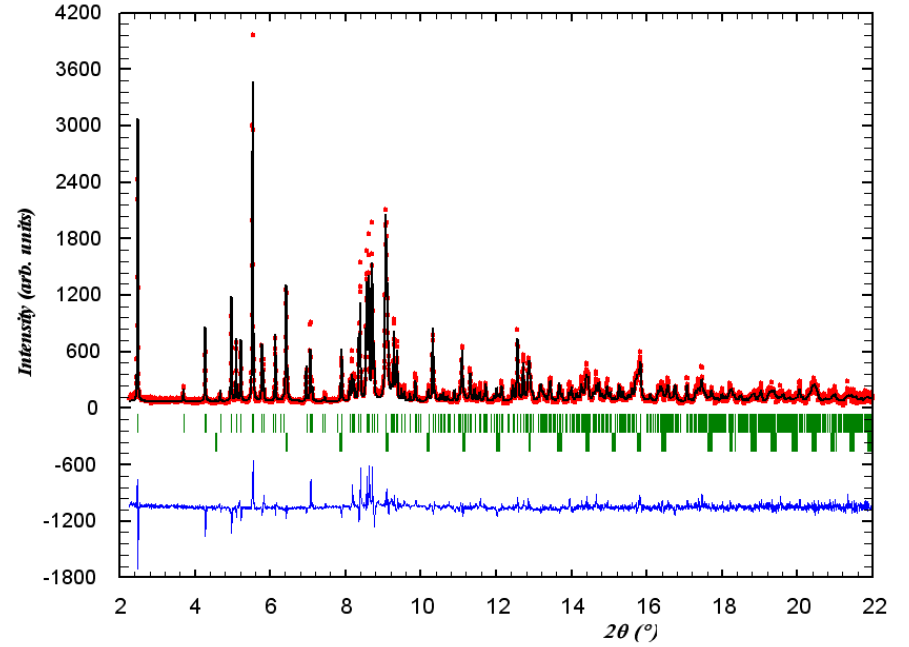
Figure 6. Scattered X-ray intensity as a function of diffraction angle. The observed pattern is shown as dots, calculated by the solid line overlaying them and difference plot is the solid line below. Reflection positions shown as vertical lines are for I in the upper row and for KIO the lower row. Atomic coordinates for KIO taken from Lucas [44] were not refined. The list of refined parameters for I contained profile 3 parameters and group isotropic thermal displacement parameters for individual chemical species. The atomic coordinates were kept fixed at the values obtained by energy minimization. Background was approximated by a simple polynomial in 2 Θ